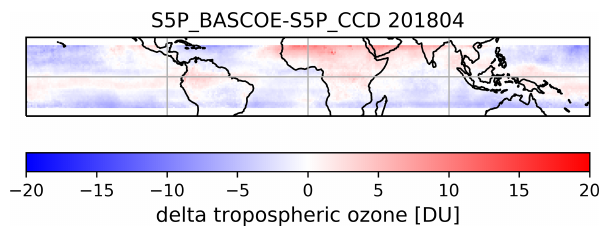
Figure 4. Monthly mean difference between S5P-BASCOE and S5P_CCD for April 2018.